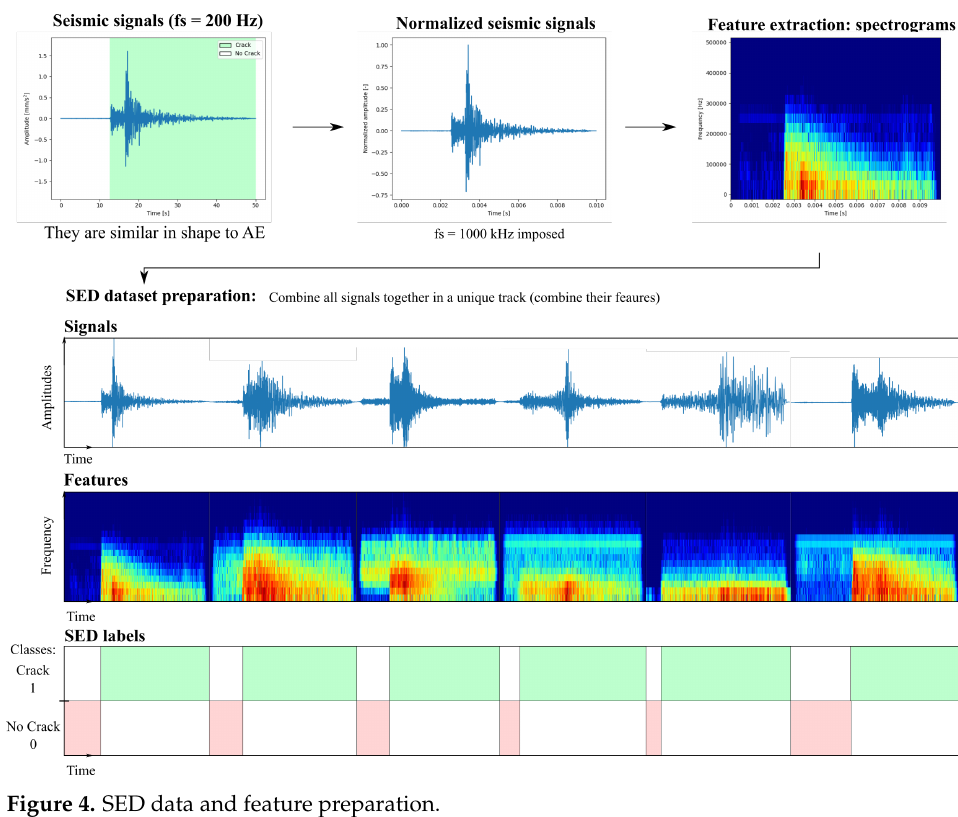
Figure 4. SED data and feature